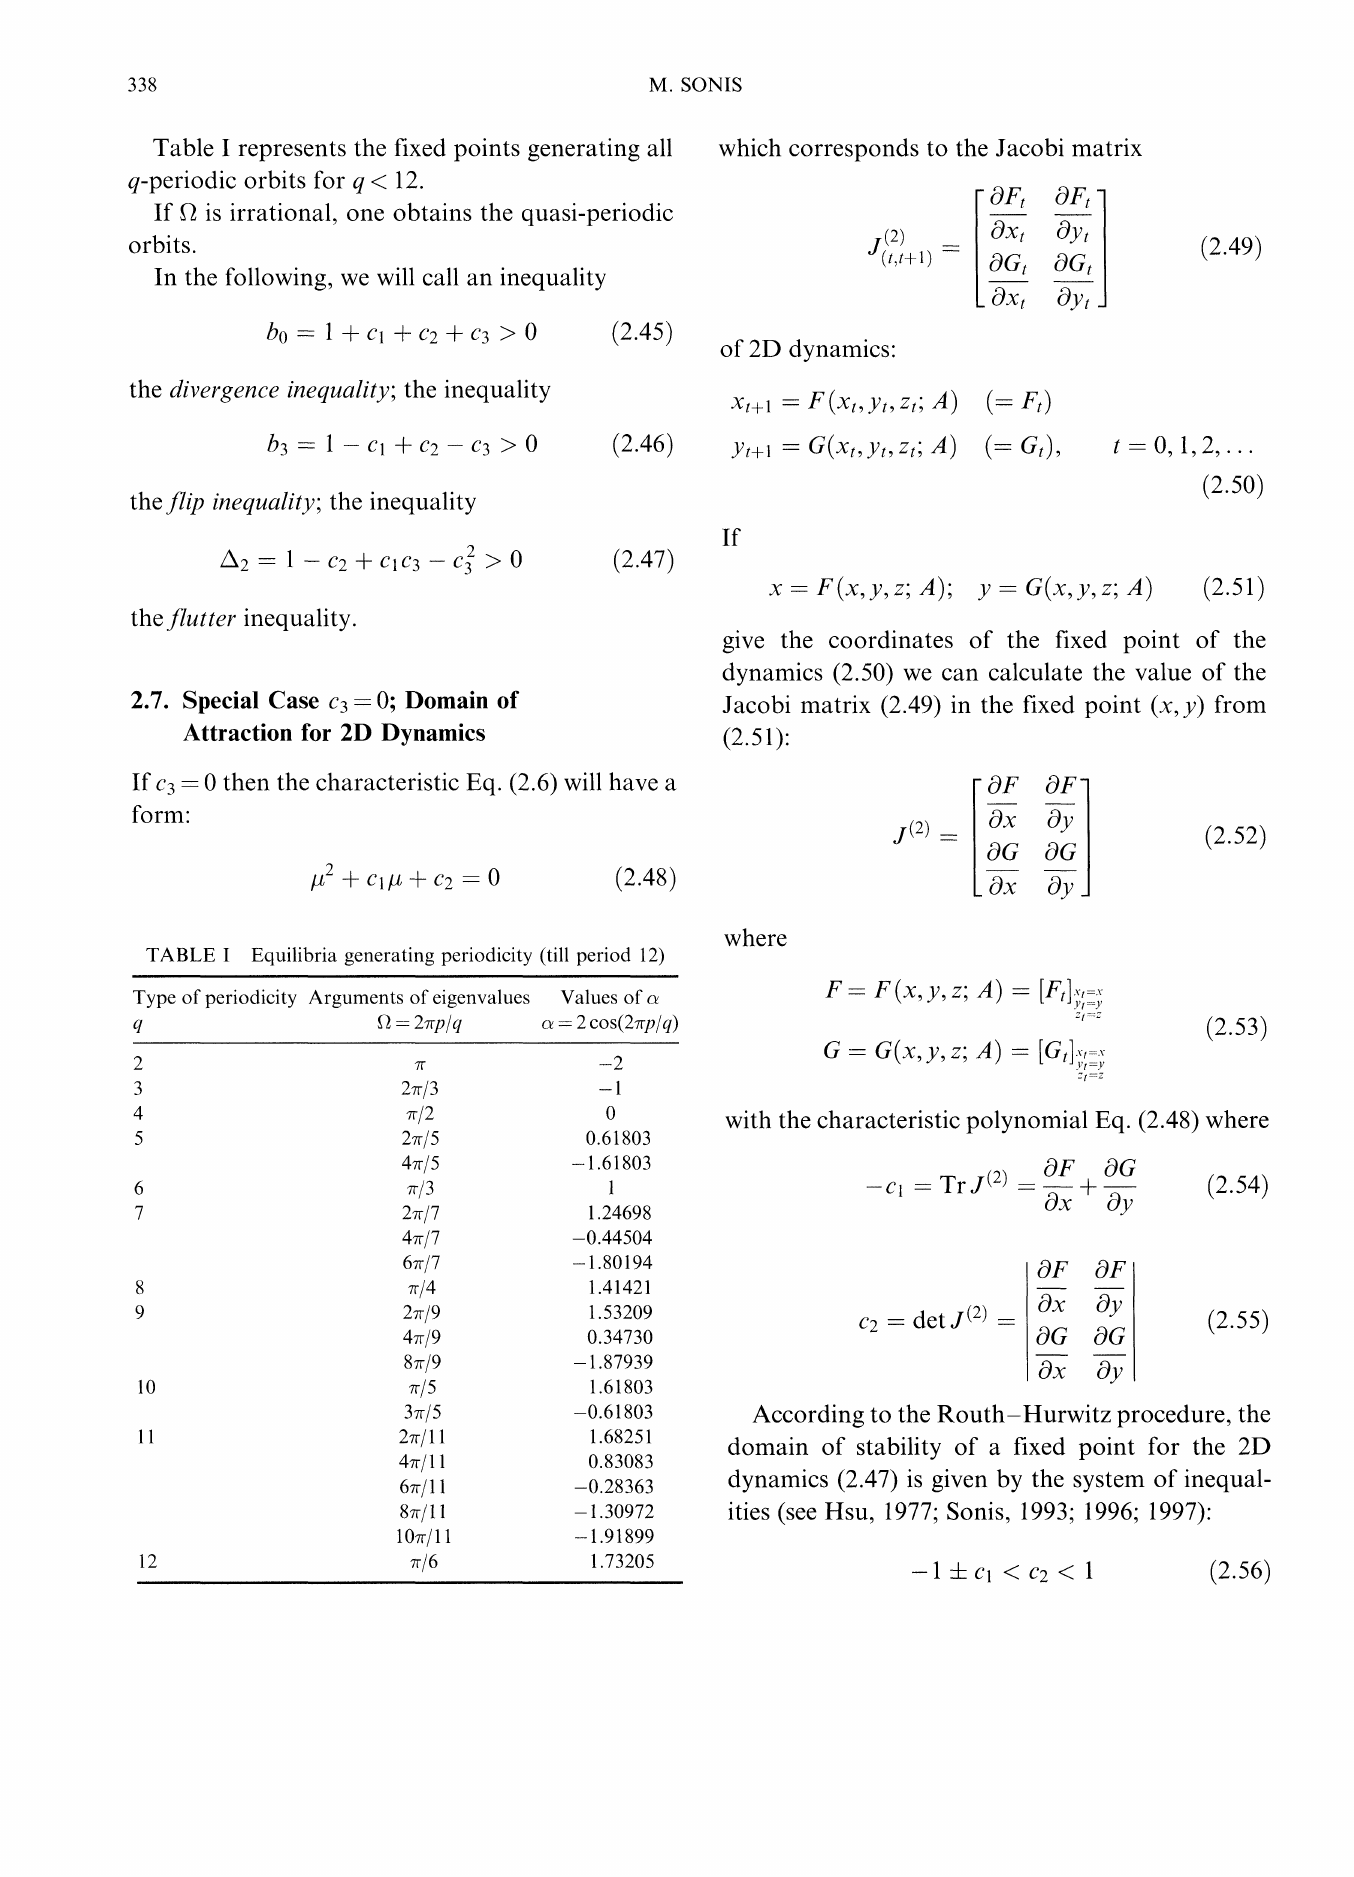
q-periodic orbits for q < 12.